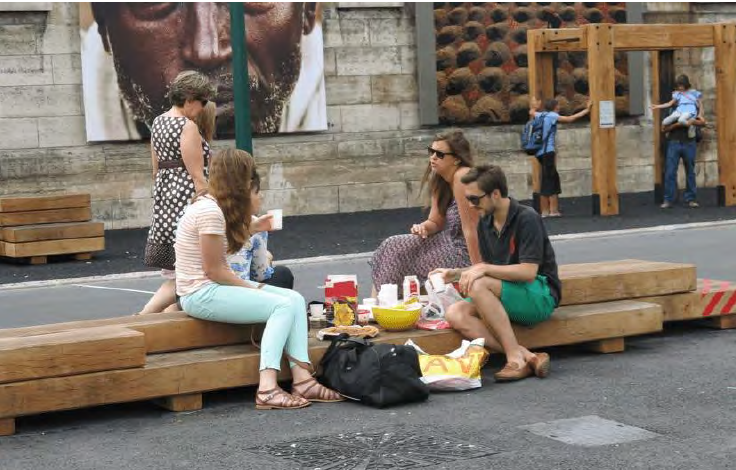
Figure 4. Paris, Les Berges. Activities seem more important than physical elements (MacKenzie, 2015)